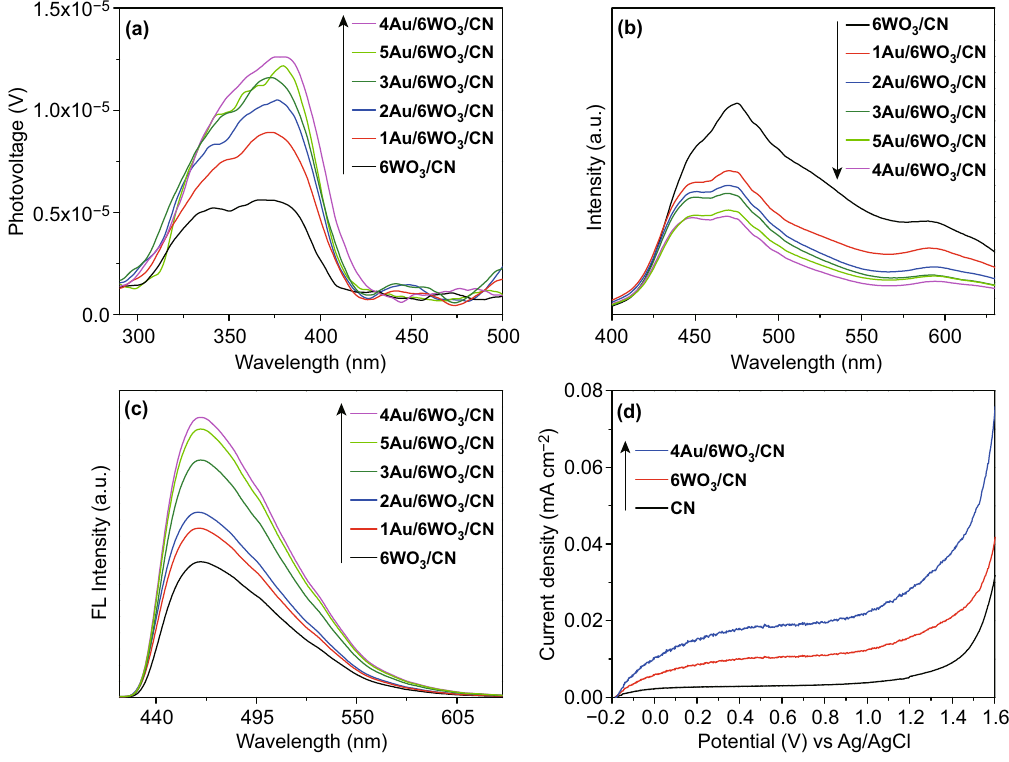
Fig. 5 a Surface photovoltage (SPV) spectra, b photoluminescence (PL) spectra, and c fluorescence spectra related to the · OH amount of 6WO 3 / CN and y Au/6WO 3 /CN composites. d Photoelectrochemical I – V curves of CN, 6WO 3 /CN, and 4Au/6WO 3